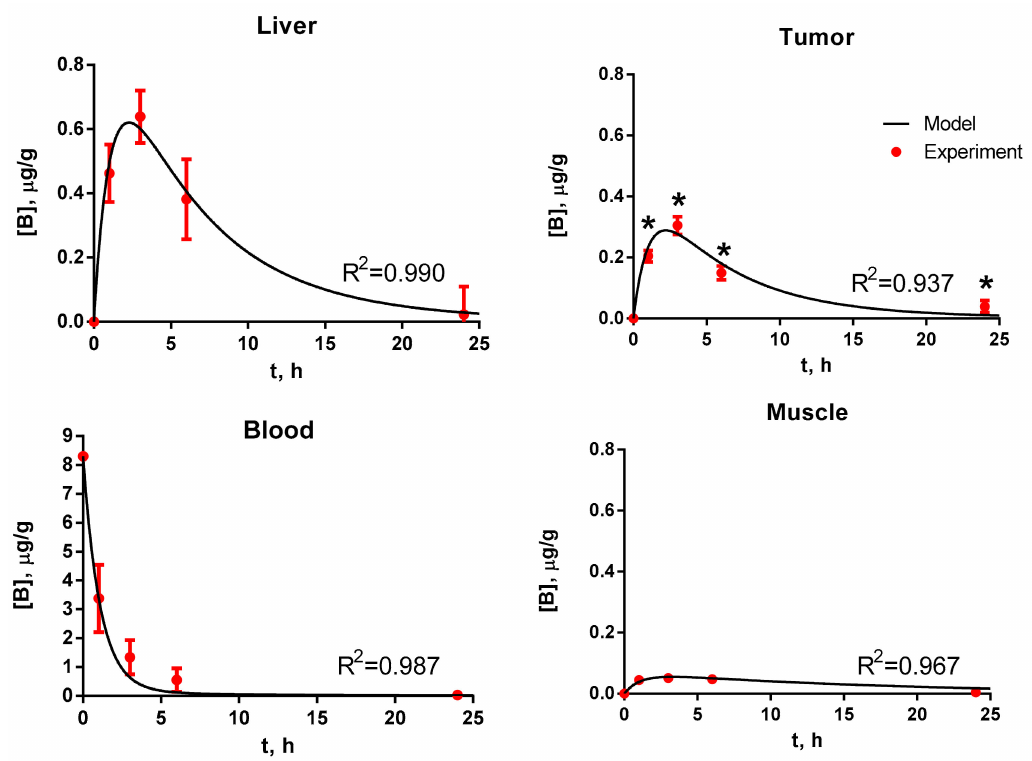
Figure 6. Pharmacokinetics of CCDC injected into the blood at a dose of 10 mg/kg. Dots denote experimental data. Lines denote the results of the solution of the mathematical